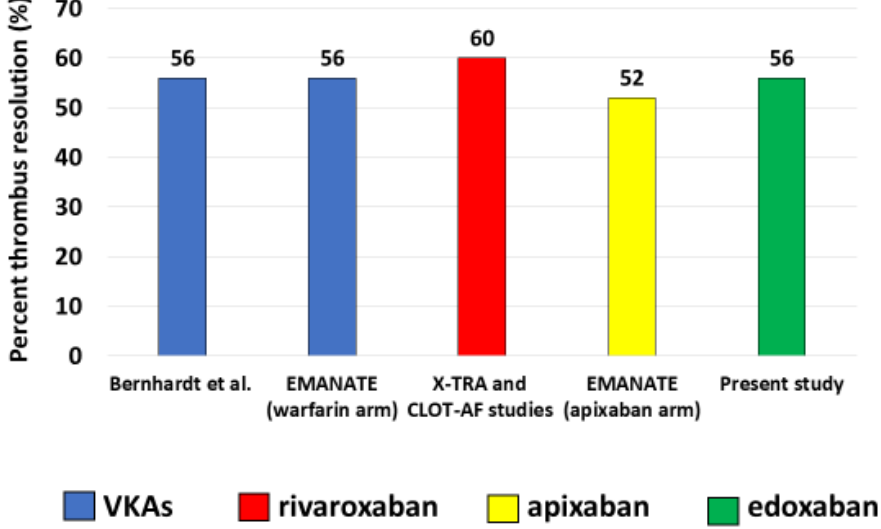
Figure 1. Percentage of complete left atrium/left atrial appendage thrombus resolution by transesophageal echocardiography with various oral anticoagulant approaches in observational and randomized cohort studies (as indicated) of patients with atrial fibrillation. VKAs = vitamin K antagonist oral anticoagulants.